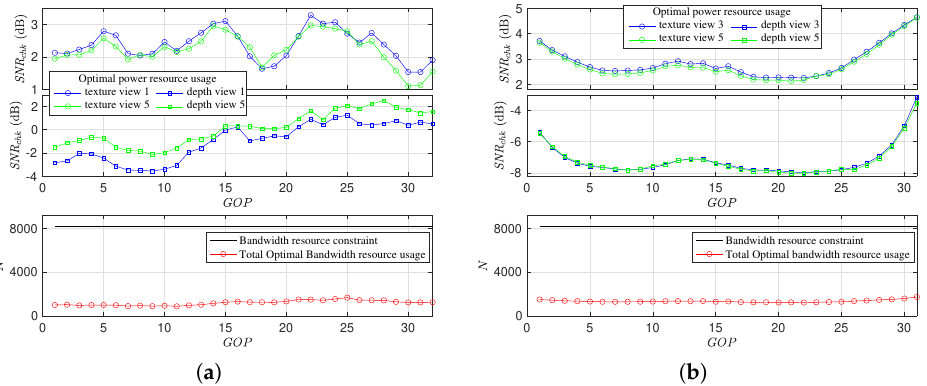
Figure 4. Power allocation for texture and depth map of 3D video sequences: ( a ) Kendo; ( b ) Poz- nanStreet.